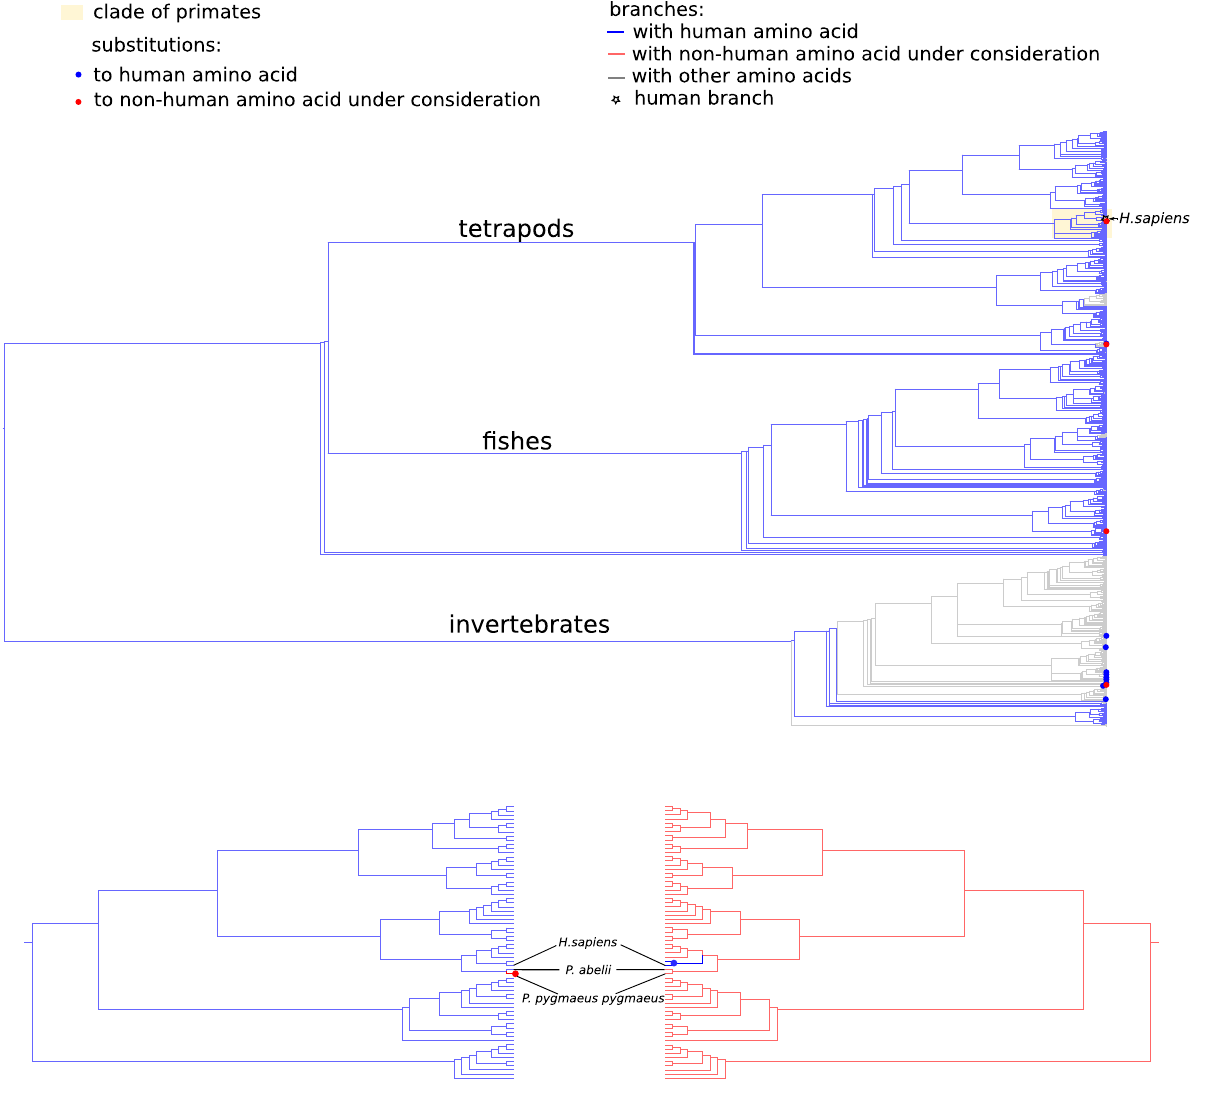
Figure 3. Substitutions to A (blue dot) and T (red dot) in sites 132 and 201 of ND1 across the dataset (top) and on a clade of Primates (bottom). Blue and red branches are occupied by A and T, respectively. White star— Homo sapiens